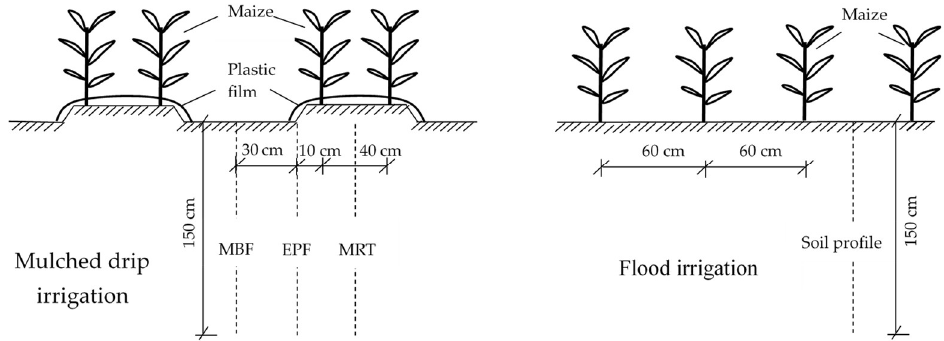
Figure 1. Schematic of the cropping patterns and observation profiles of soil water content.